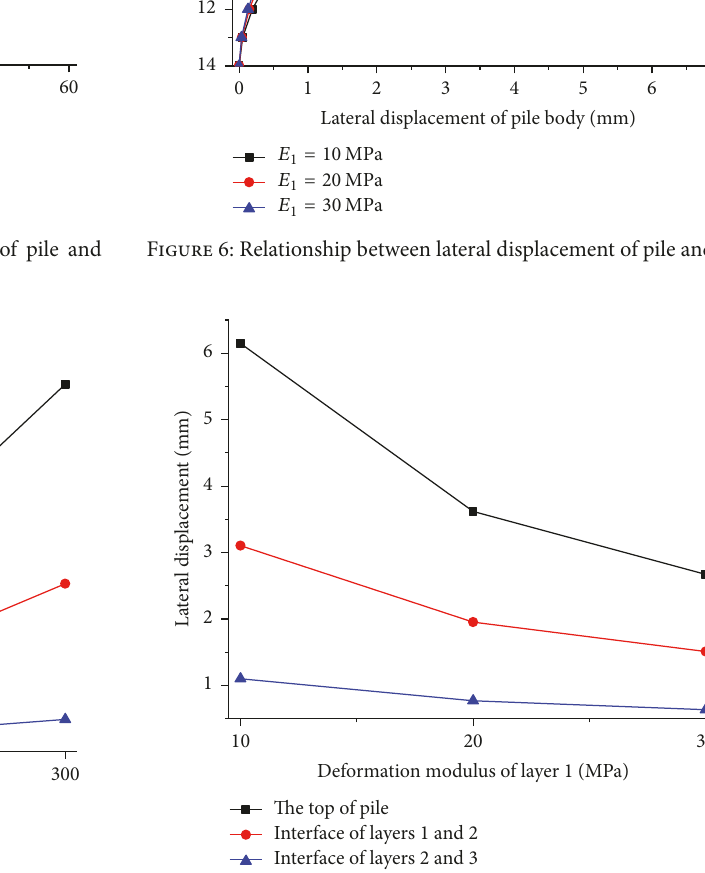
Figure 7: Relationship between lateral displacement and 𝐸 1 at different